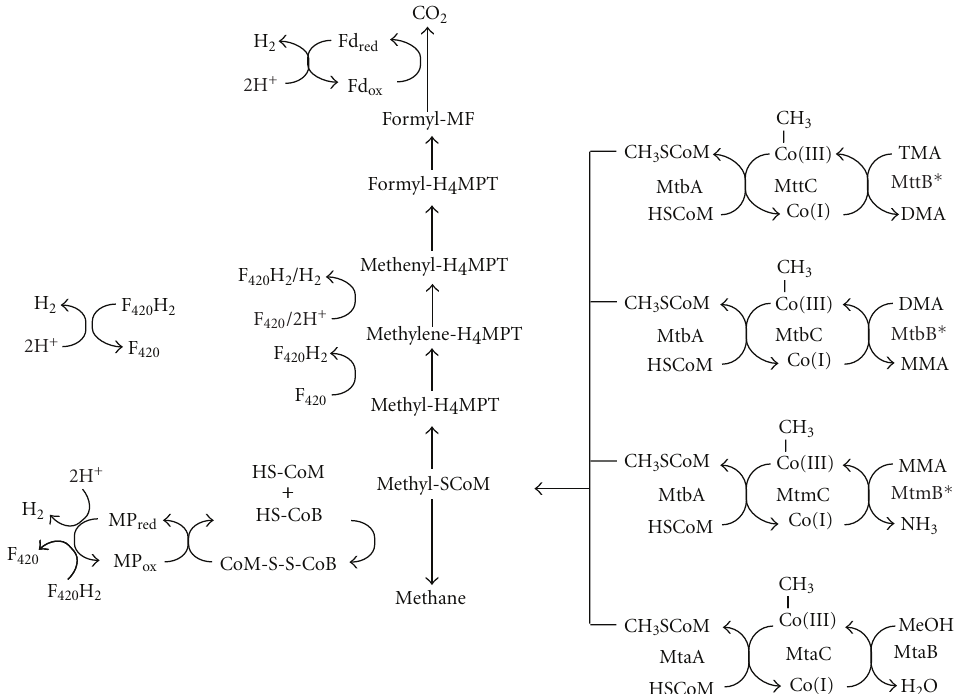
Figure 2: Scheme of methylotrophic methanogenesis. Methyl groups from methanol, TMA, DMA, and MMA are mobilized into metabolism by the action of a substrate-specific methyltransferase interacting with its cognate corrinoid protein in which the cofactor’s cobalt ion cycles between methyl-Co(III) and Co(I) states. Methyltransferases that are pyrrolysyl-proteins are marked with an asterisk. The corrinoid cofactor is then demethylated by the action of a methylcobamide:CoM methyltransferase such as MtbA (for methylamines) or MtaA (for methanol). Adventitious oxidation can inactive the corrinoid proteins to the Co(II) state, which can be reductively reactivated by RamA (for methylamines) and possibly by RamA homologs for other pathways. Reducing equivalents in the form of hydrogen, F 420 H 2 , or Fd red from the oxidation of methyl-CoM are used to reduce methanophenazine (MP) and subsequently CoM-S-S-CoB, thereby generating ATP via electron transport phosphorylation and the free HS-CoM and HS-CoB cofactors; CoM-S-S-CoB is then recycled by the reduction of methyl-CoM to methane. See Figure 1 for cofactor